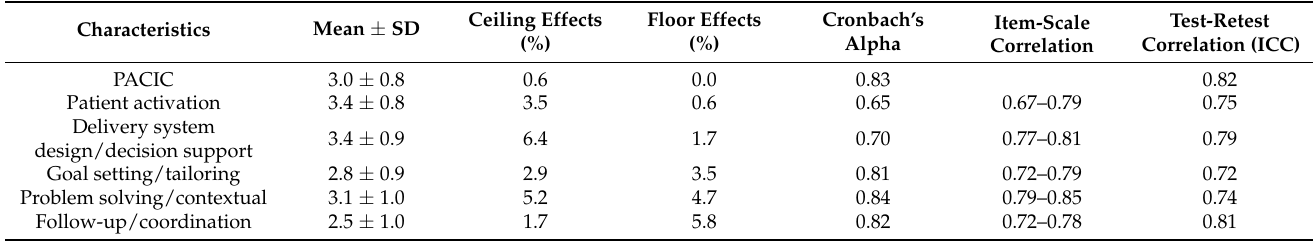
Table 2. Descriptive statistics, score distributions and internal reliability of a Korean translation of the PACIC survey scale in patients on hemodialysis.